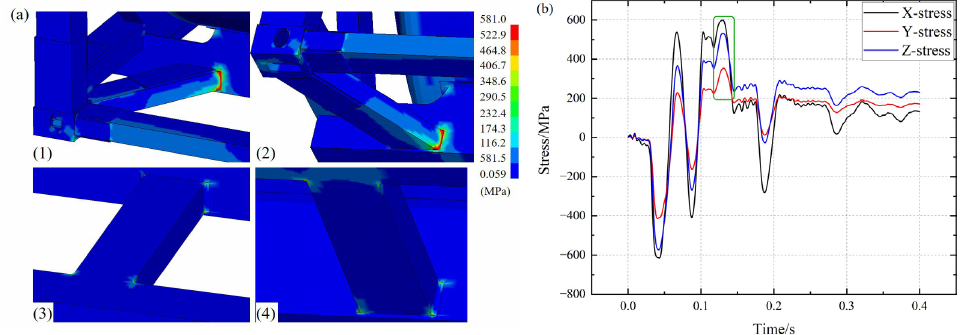
Figure 24. Stress distribution at peak value 5: ( a ) location; ( b ) change of stress state in chamfer.